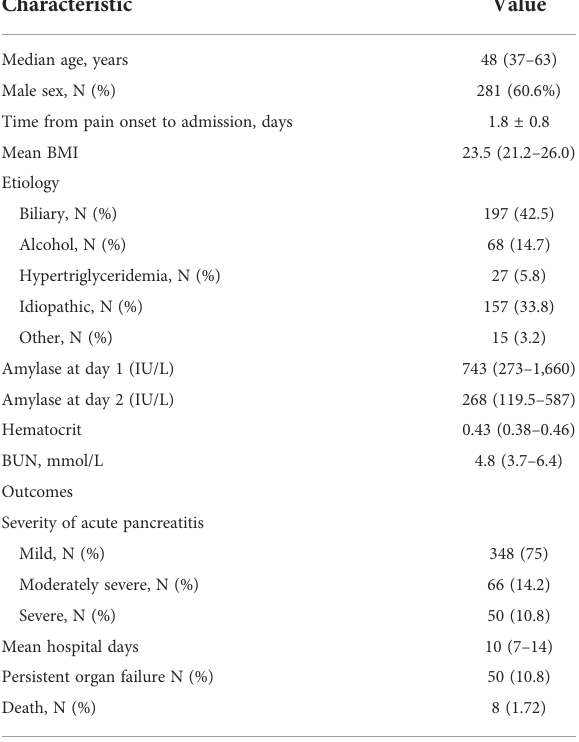
TABLE 1 Demographic and Clinical Characteristics of 464